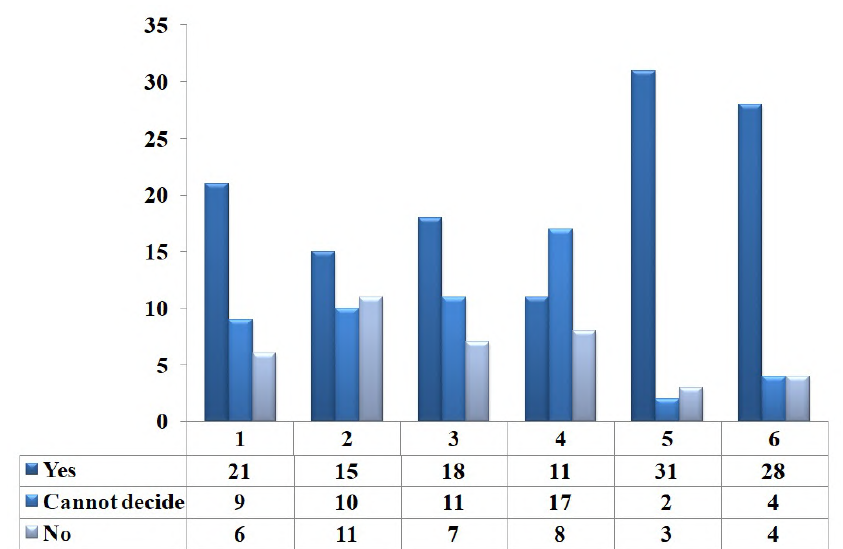
Figure 8: Visualization of the structure of physical education teachers, responses to the questionnaire aimed at determining attitudes toward the use of augmented reality in the educational process to preserve students, health and develop their motor skills, intelligence and creativity (see questionnaire in “Selection of methods and